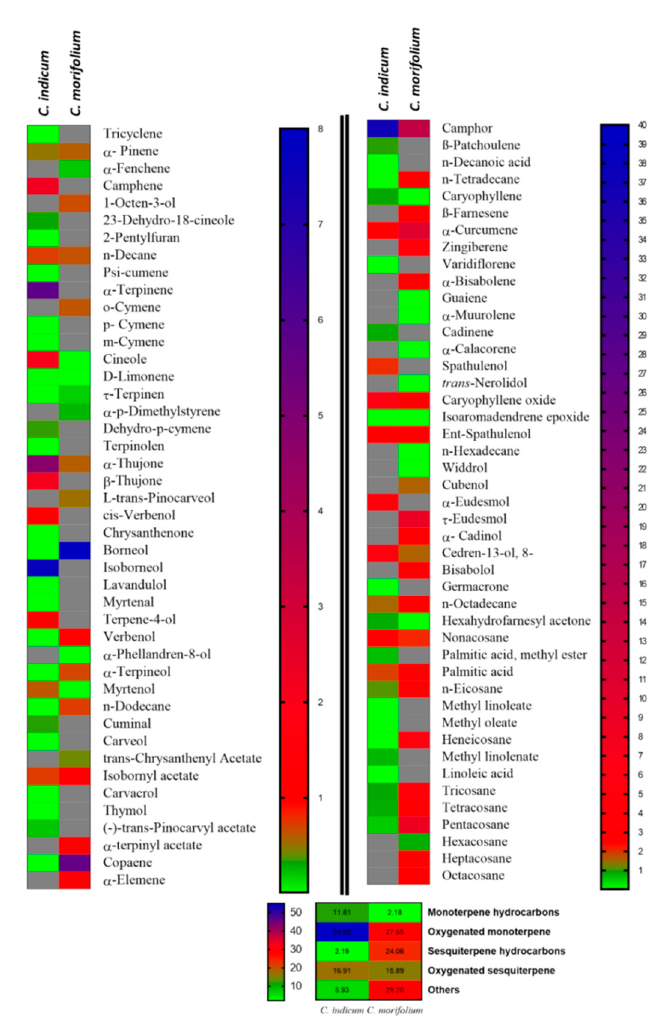
Figure 3. Major constituents of C. indicum and C. morifolium essential oils.